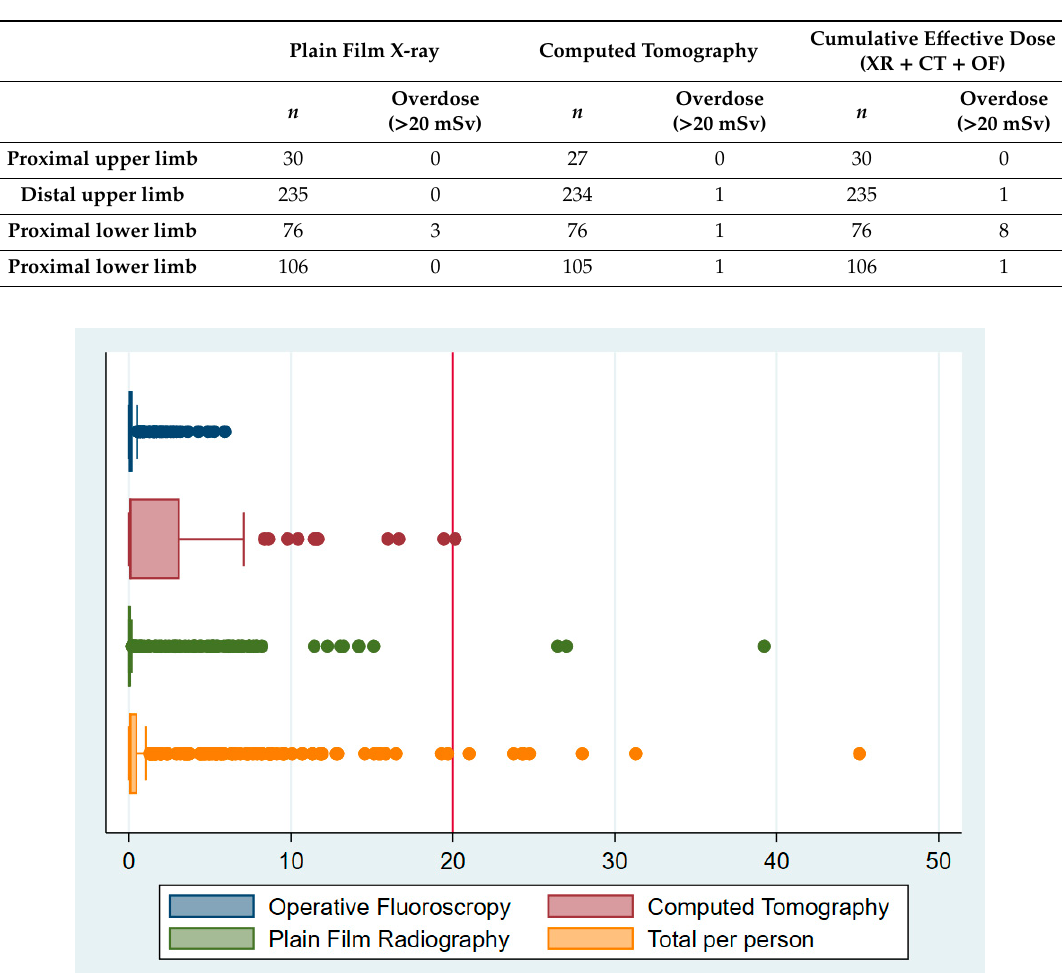
Figure 1. Radiation exposure by type.